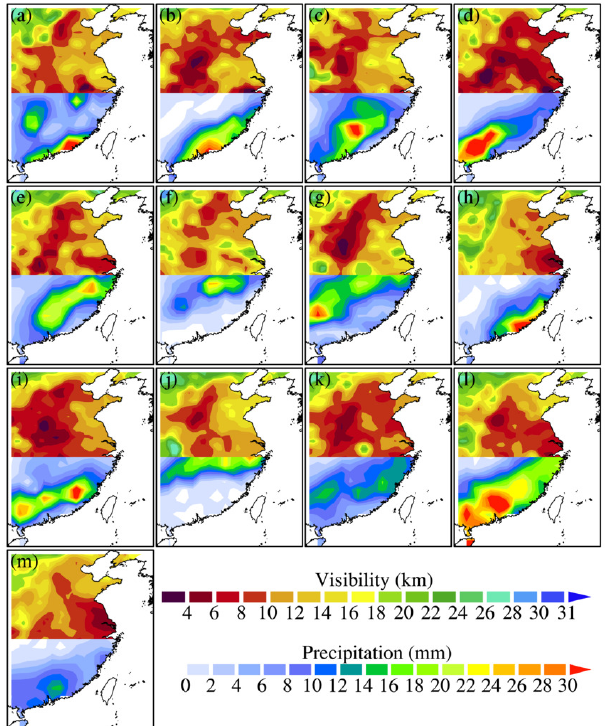
Figure 2. Daily mean visibility (shading, kmd − 1 ) over the NCP (30–40 ◦ N, 112–120 ◦ E) and precipitation (shading, mmd − 1 ) in southern China (10–20 ◦ N, 110–120 ◦ E) for each south rainfall– north haze (SR–NH) event. Panels (a–n) represent events 1–13, re- spectively, as described in Table 1.